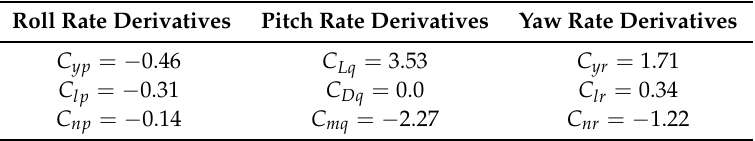
Table 8. Longitudinal and Lateral Dynamic